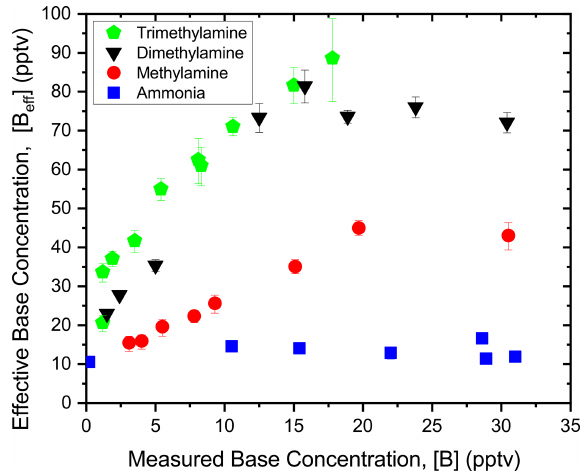
Figure 2. Comparison of [ B eff ] and measured dimethylamine (DMA) concentration for multi-component injections. Mixture ex- periments for DMA (black triangles), DMA with 73pptvNH 3 (blue diamonds), DMA with 7pptvMA, 40pptvNH 3 , and 2pptvTMA (green squares), and DMA with 3pptvMA and 15pptvNH 3 (orange circles). The average sulfuric acid concentration was 1 × 10 8 cm − 3 , and the reaction time was